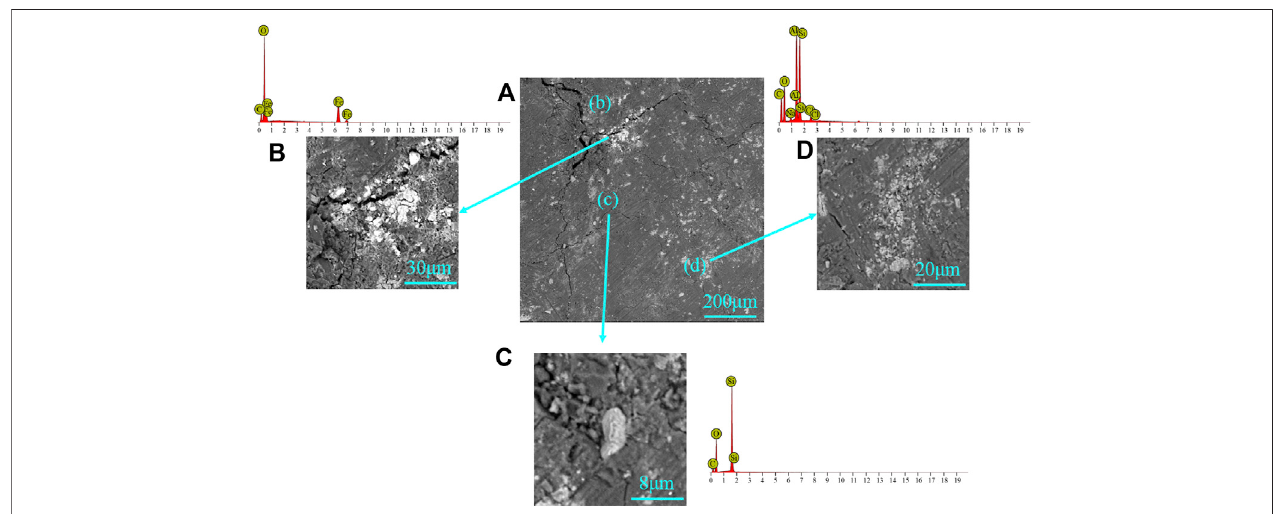
FIGURE 1 | SEM-EDS for the mineral in the coal sample: (A) coal matrix, (B) siderite, (C) quartz, and (D) kaolinite.